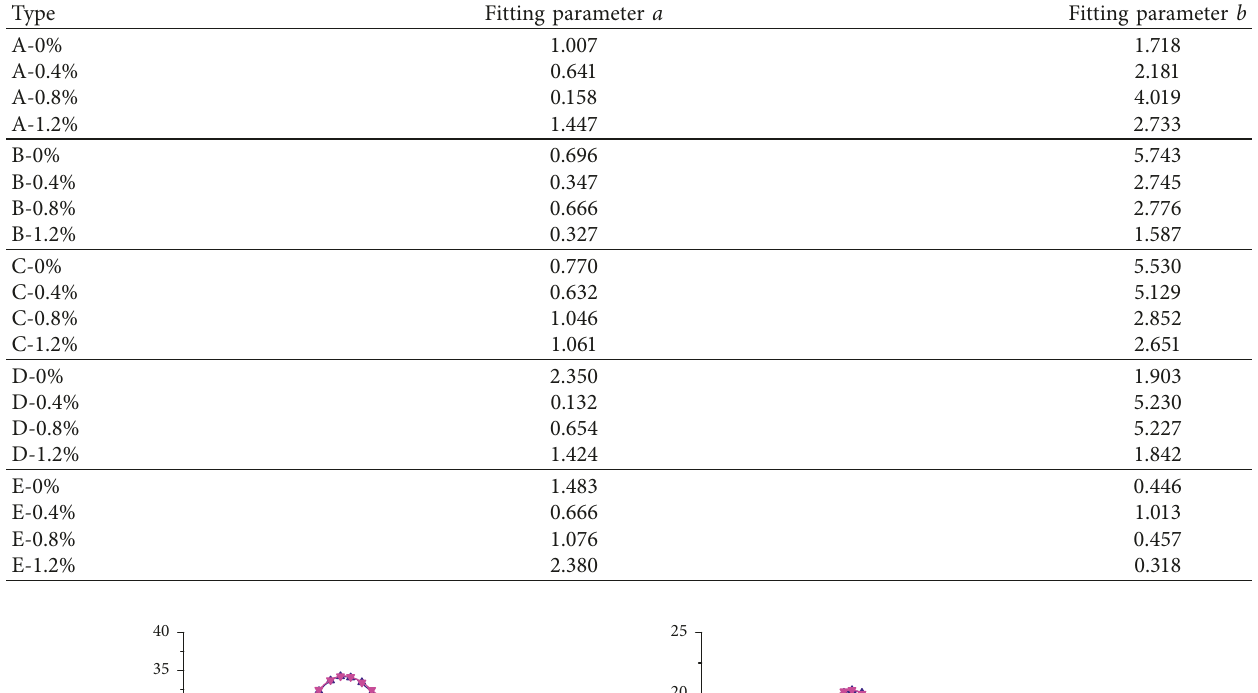
Table 5: Fitting parameters a and b based on the GZH model.